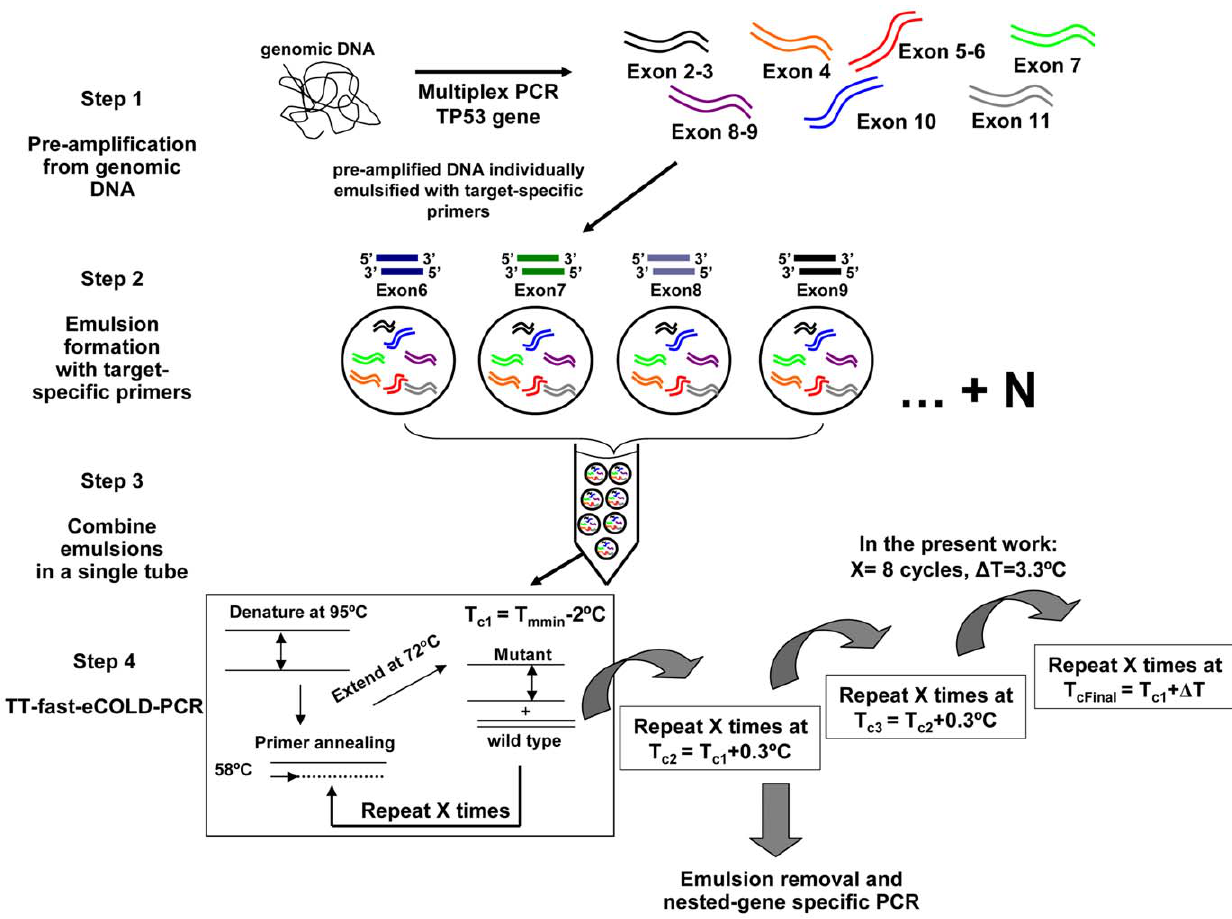
Figure 1. Temperature-tolerant-fast-COLD-PCR in emulsion: Overview of the steps involved. Multiplex pre-amplification from genomic DNA; emulsification with gene-specific primers; mixing into a single tube; and temperature-tolerant emulsion-based fast-COLD-PCR.